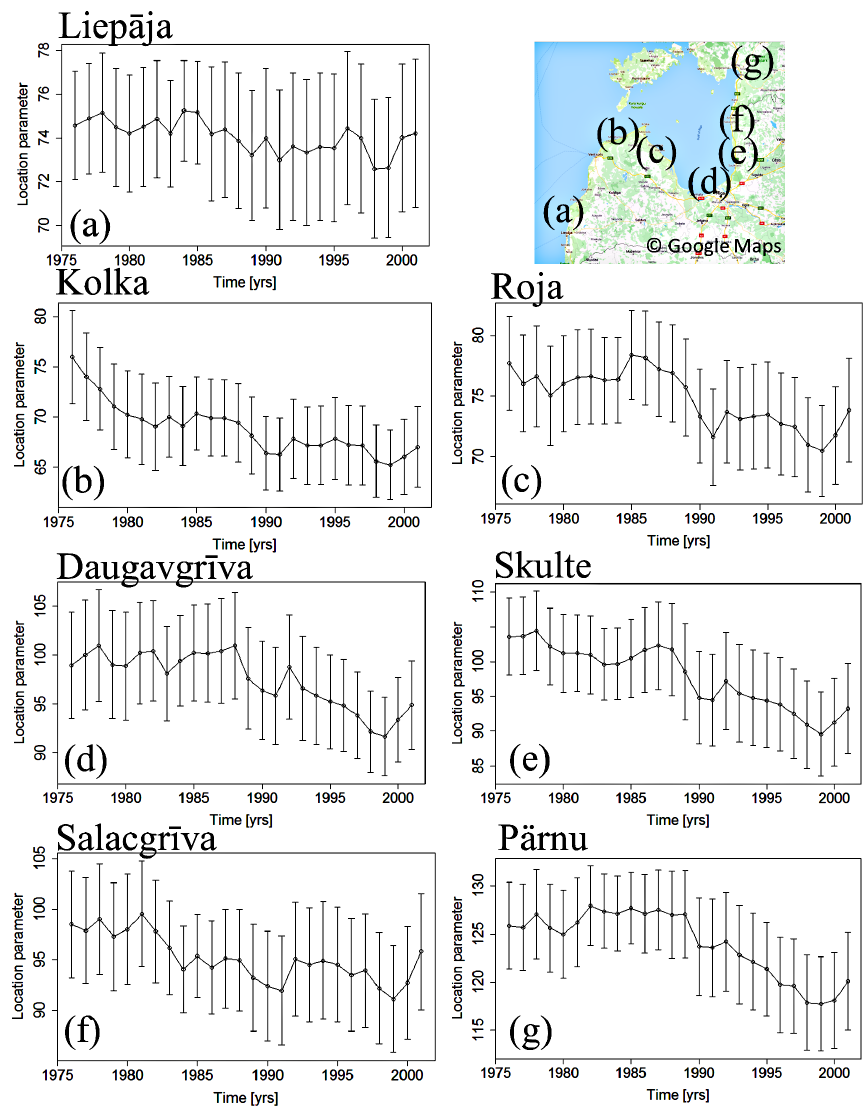
Figure 5. Location parameter µ as a function of time for all tide gauges and 95% confidence intervals of its estimates. The presented estimates were derived using a sliding-GEV fit with a window of 30 years. The time on the plots corresponds to the time in the middle of this